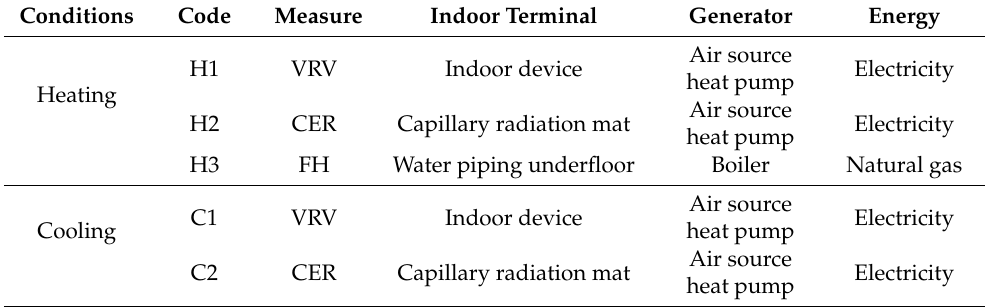
Table 1. Alternative heating and cooling measures for residential buildings in Shanghai.